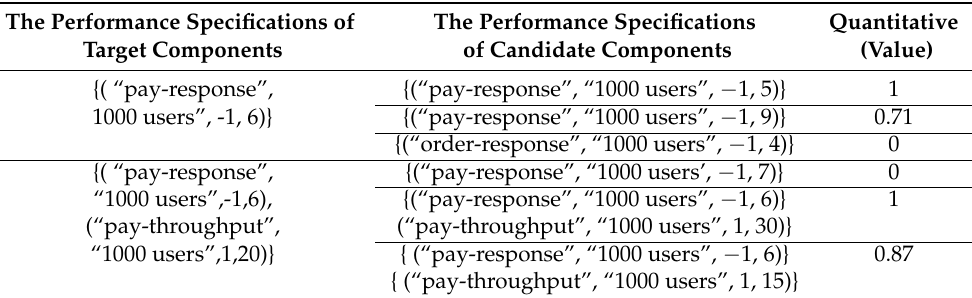
Table 2. The performance quantification of Components.